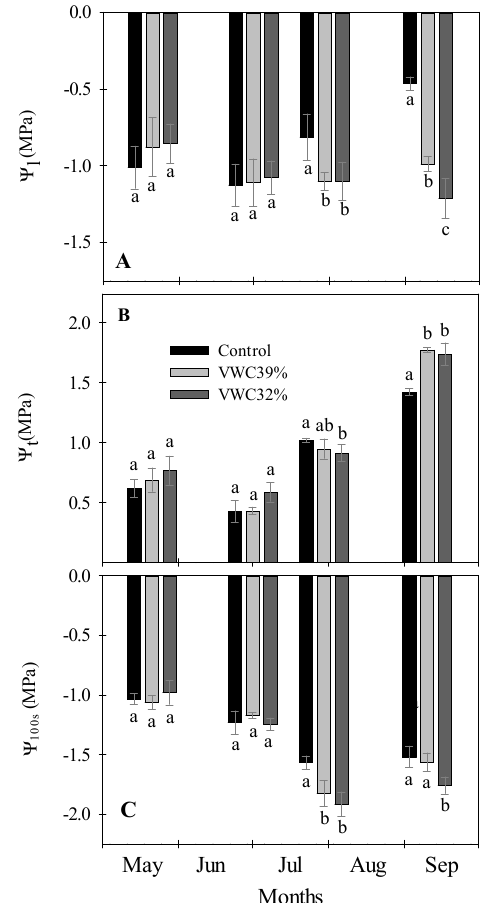
Figure 4. Water–plant relations in Hebe during the experiment: leaf water potential at midday ( Ψ l ) ( A ), leaf turgor potential ( Ψ t ) ( B ), and leaf osmotic potential at full turgor ( Ψ 100s ) ( C ). Control (black), VWC39% (light gray), and VWC32% (dark gray) indicate Hebe plants cultivated at 49.28%, 38.44%, and 32.16% VWC, respectively. Values are means ( n = 5) and vertical bars indicate ± standard error. Different letters indicate statistically significant differences between means at p < 0.05 according to the least significant difference (LSD) test.